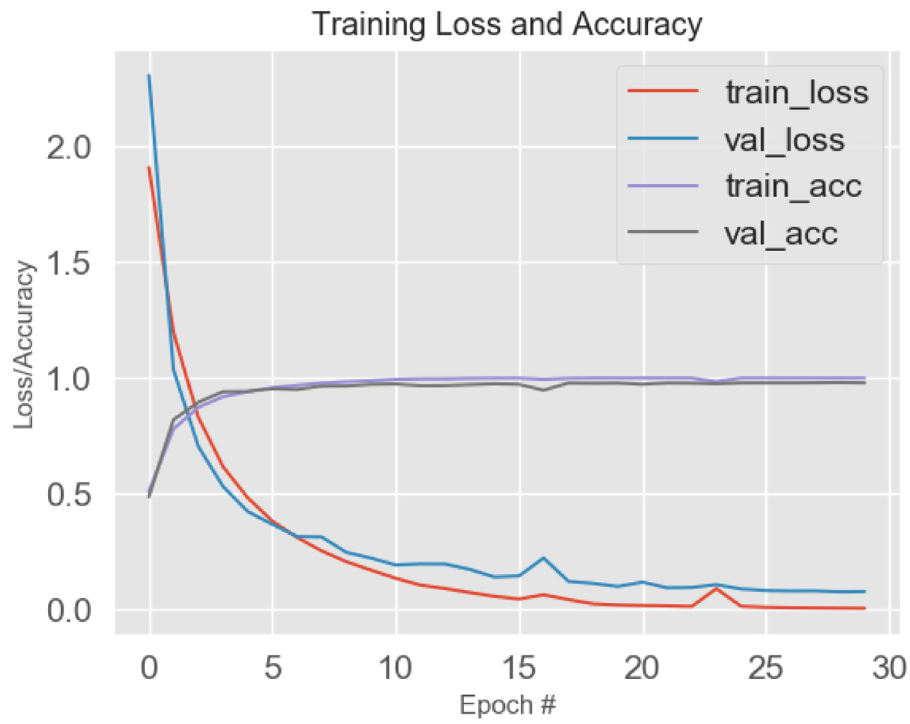
Fig 10. Training and validation performances using a proposed model with ECG datasets.